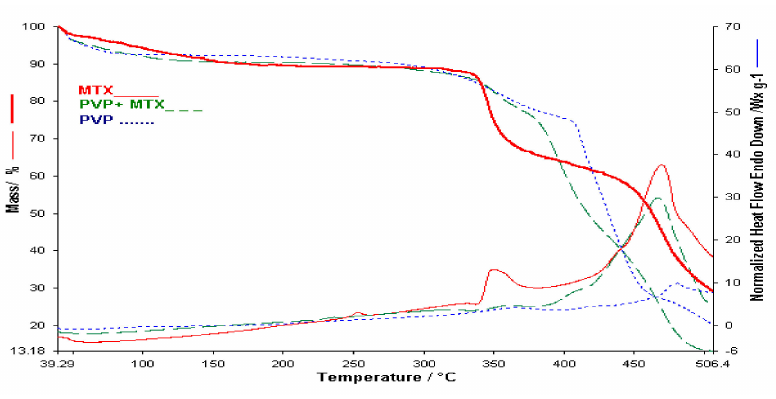
Figure 4. TGA/HF curves for MTX, PVP and Binary